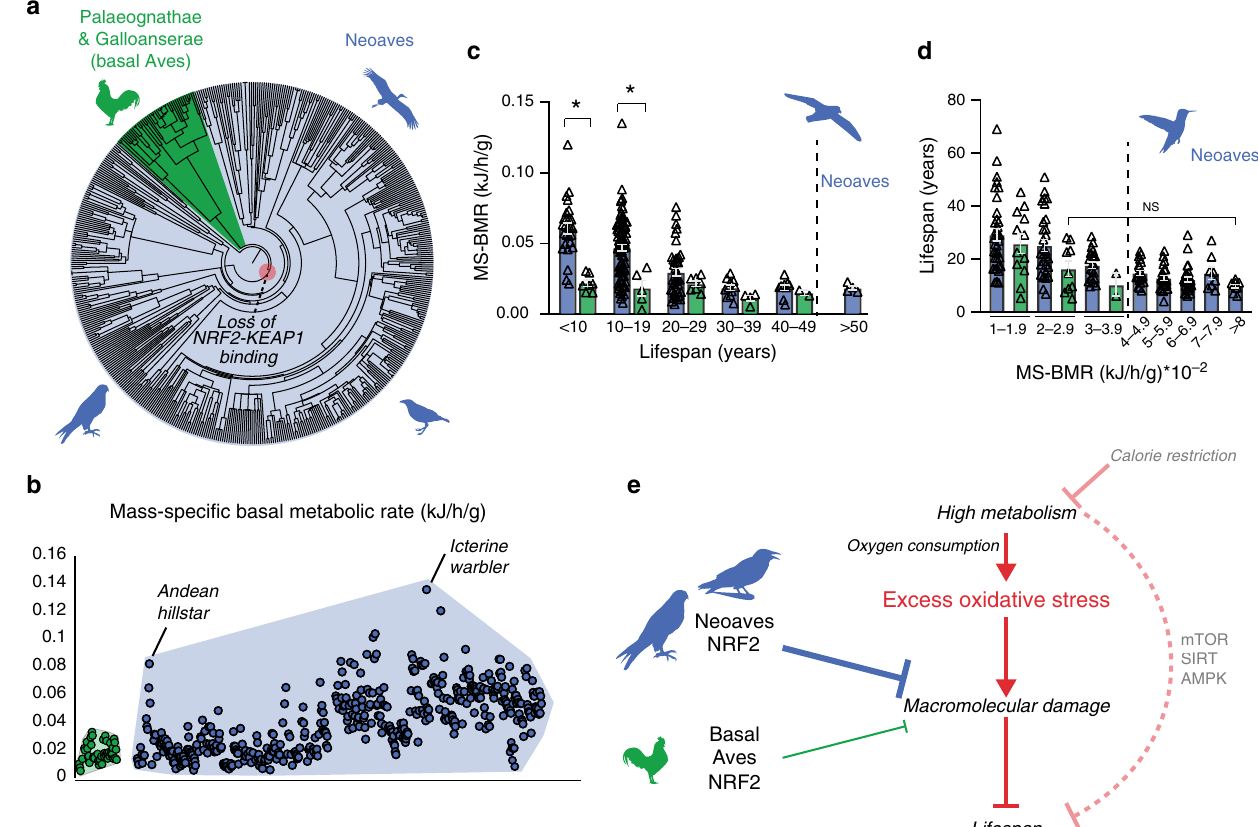
Fig. 5 Diversi fi cation of lifespan and metabolic rates in Neoaves. a Phylogenetic relationships of avian taxa for which mass-speci fi c basal metabolic rates (MS-BMR) are available ( “ Methods ” ). Red highlight denotes the Neoavian ancestor where KEAP1 binding of NRF2 was lost. b MS-BMR reach higher ranges in Neoaves (blue) species relative to basal Aves (green). Avian orders are grouped by phylogenetic relationships along the X -axis ( “ Methods ” ). c MS-BMR differs signi fi cantly between Neoaves and basal Aves species with equivalent lifespans (<10 years, p = 0.03; 10 – 19 years, p = 0.02; PI Kruskal – Wallis; Supplementary Fig. 9, Supplementary Tables 10 and 11). Neoaves with low MS-BMR reach higher lifespans than any basal Aves (>50 years). Neoaves: n = 180 biologically independent animals; basal Aves: n = 25 biologically independent animals. Data are presented as mean values. d Neoaves with MS-BMR values higher than that of any basal Aves still maintain statistically indistinguishable lifespans, despite a nearly fourfold increase in MS-BMR (Kruskal – Wallis; Supplementary Table 10). Neoaves: n = 175 biologically independent animals; basal Aves: n = 23 biologically independent animals. Data are presented as mean values. e High metabolism impacts lifespan through nutrient-sensing pathways (mTOR, SIRT, AMPK) as well by generating excess oxidative stress, aggravating age-associated cellular and molecular damage (see “ Discussion ” for references). An enhanced NRF2 antioxidant response via the loss of KEAP1 would likely lower the risk of macromolecular oxidative damage expected to result from high avian metabolism and oxygen consumption. By altering redox homeostasis to tolerate higher levels of excess oxidative stress, the loss of KEAP1 may have enabled these increases to Neoaves lifespan and metabolic rates. Source data are provided as a Source data fi le. All error bars represent standard error. * = phylogenetic statistical signi fi